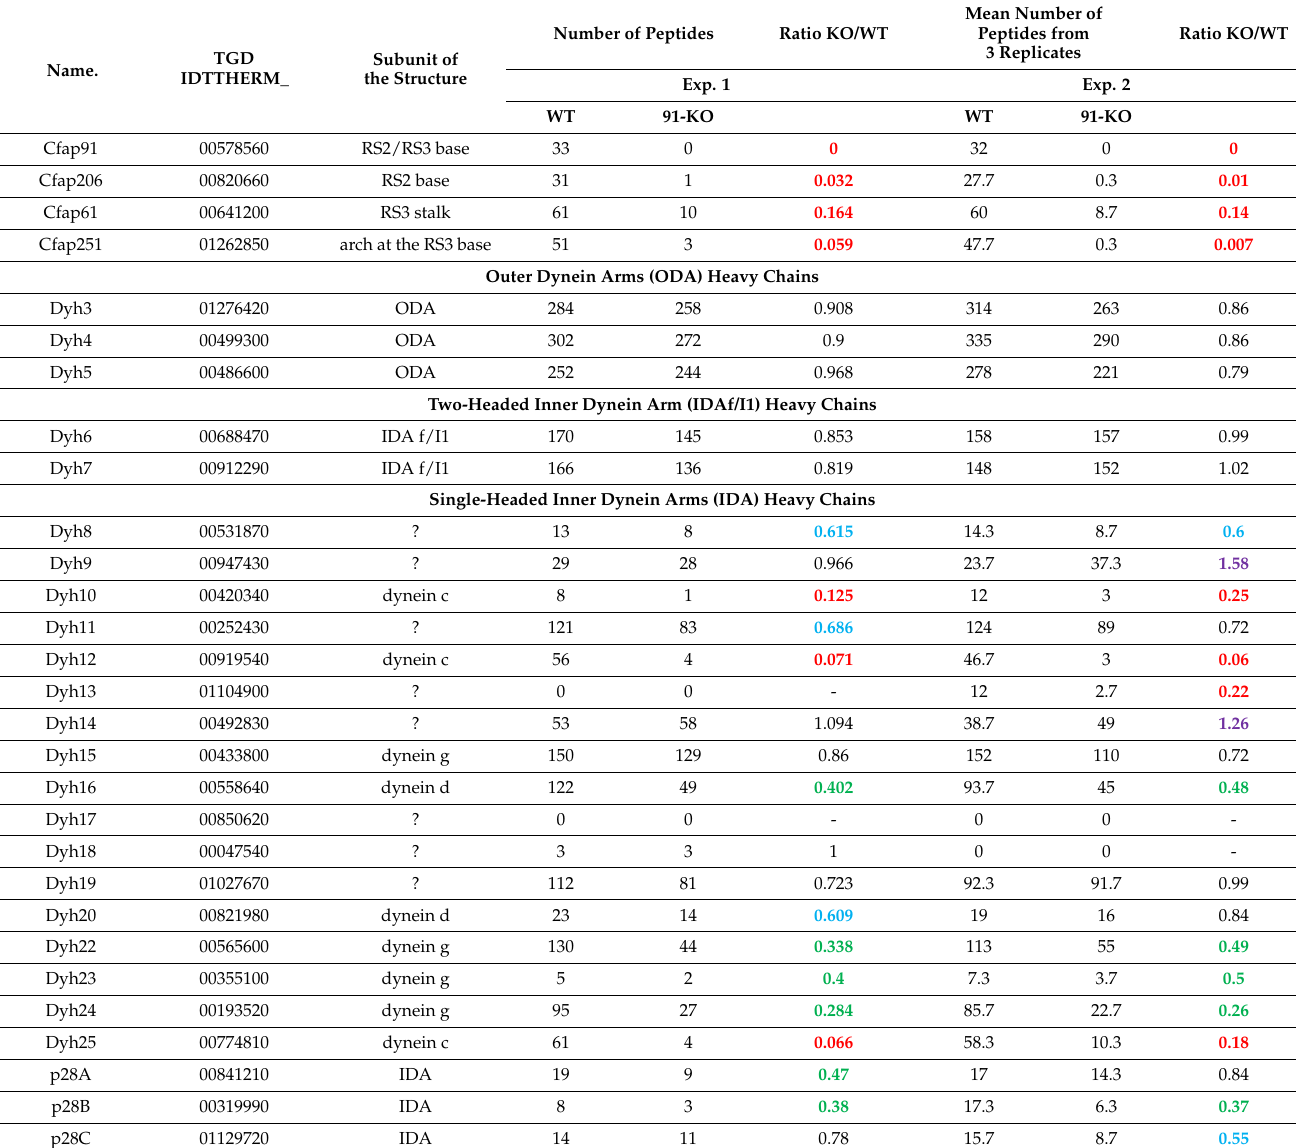
Table 2. The levels of proteins associated with radial spokes base and dynein arms in wild-type and CFAP91-KO mutant